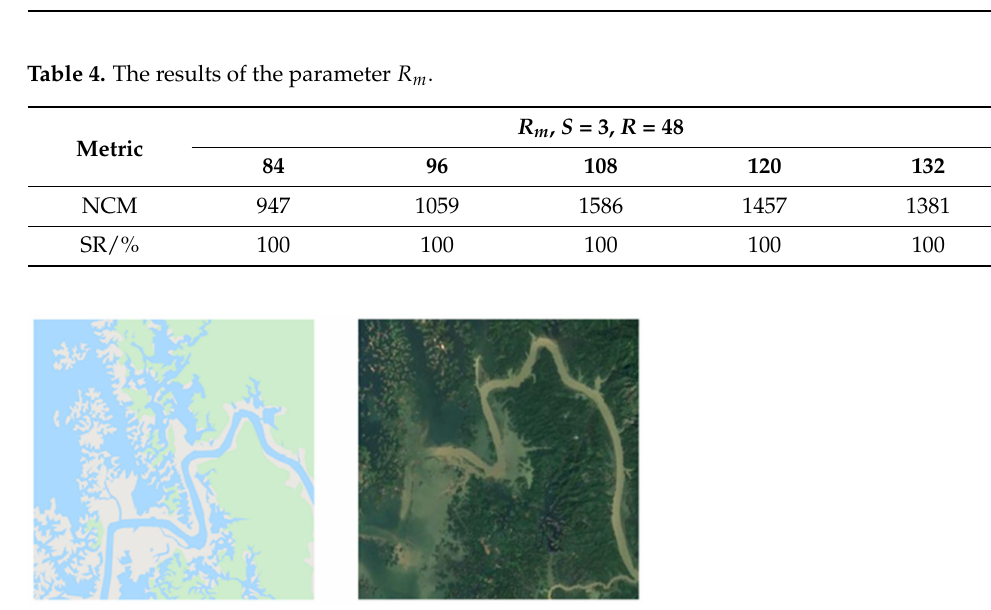
Figure 8. Image pairs for parameter study